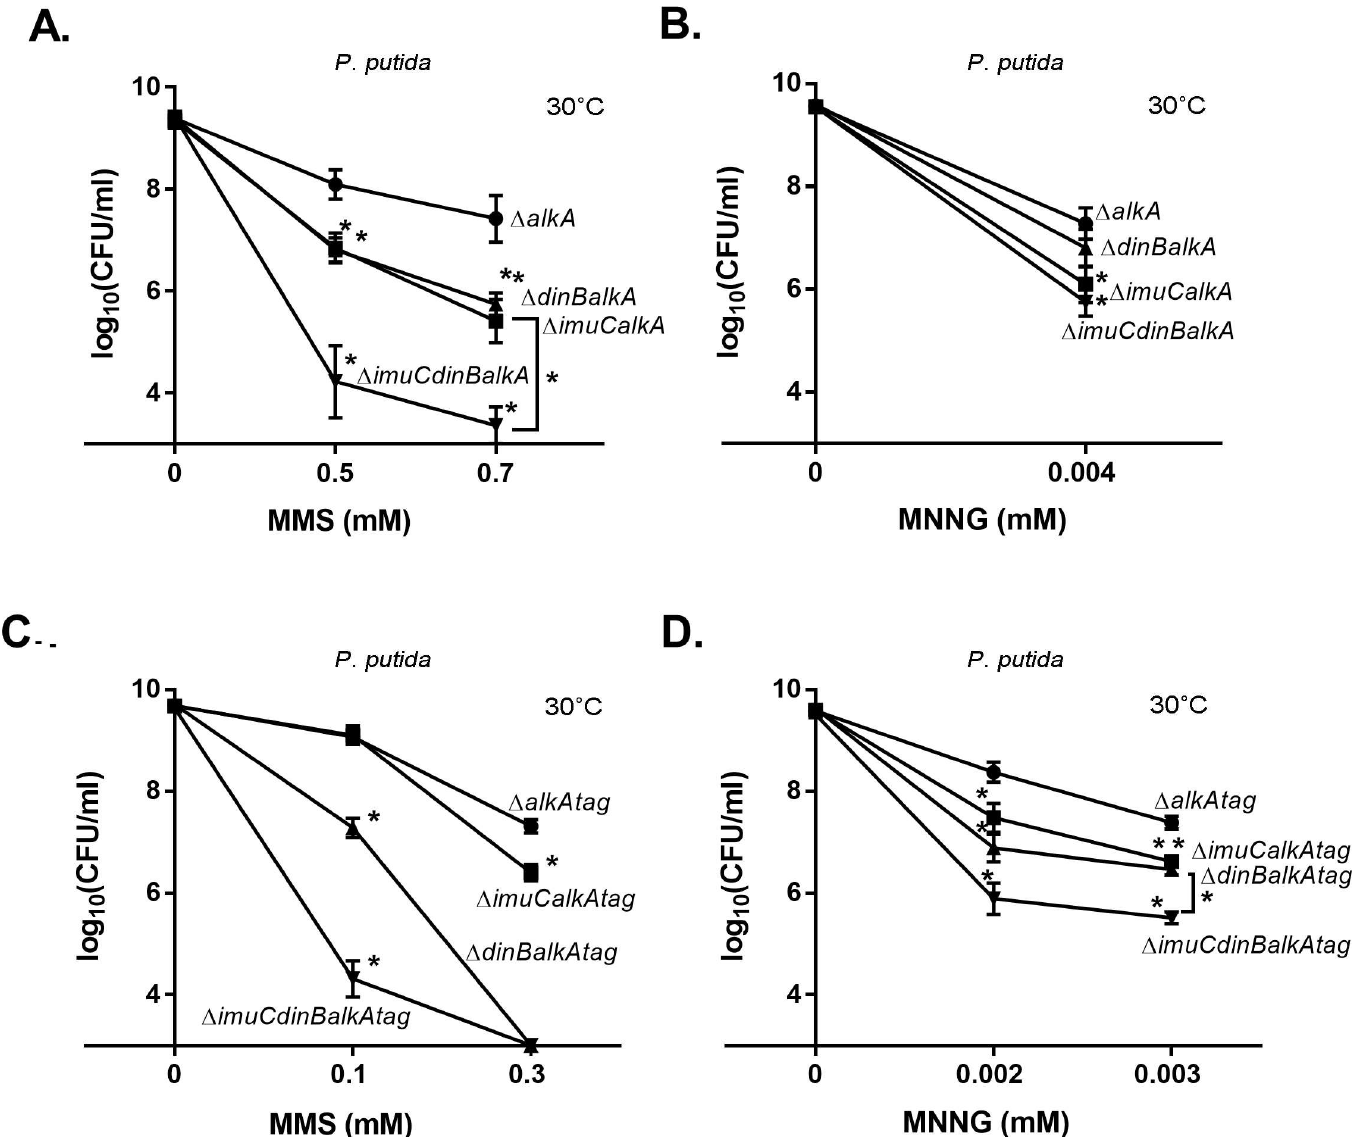
Fig 4. Sensitivity of P . putida Δ alkA and Δ alkAtag strains and their different TLS polymerase-deficient derivatives to MMS and MNNG. Sensitivity was estimated by spotting 10-fold dilutionsof overnightcultures of P . putida Δ alkA (A, B) and Δ alkAtag (C, D) strains onto LB plates containing different concentrations MMS (A, C) and MNNG (B, D) and incubatedat 30˚C for 24 h. Data represents the mean ( ± 95%CI)values. ( ● ) Δ alkA ; ( ■ ) Δ imuCalkA ;( ▲ ) Δ dinBalkA ;( ▼ ) Δ imuCdinBalkA (A, B); ( ● ) Δ alkAtag ;( ■ ) Δ imuCalkAtag ; ( ▲ ) Δ dinBalkAtag ; ( ▼ ) Δ imuCdinBalkAtag (C, D). Asterisks indicatestatistically significantdifference ( P < 0.05; two-way ANOVA followedby Tukey’s multiplecomparisonpost hoc test) in the sensitivity of the Δ alkA or the Δ alkAtag mutant in comparisonwith the other deletionmutants. In addition,significantdifference in sensitivity betweenthe Δ dinBalkA or Δ imuCalkA and the Δ imuCdinBalkA (A); Δ dinBalkAtag or Δ imuCalkAtag and the Δ imuCdinBalkAtag strains (D) is